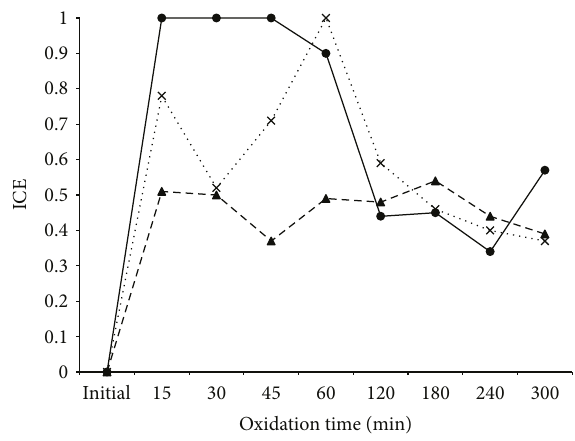
Figure 3: Instantaneous current e ffi ciency (ICE) for the anodic oxidation process: 3.5mA/cm 2 ( ● ), 7.0mA/cm 2 ( ▲ ), and 10 mA/ cm 2